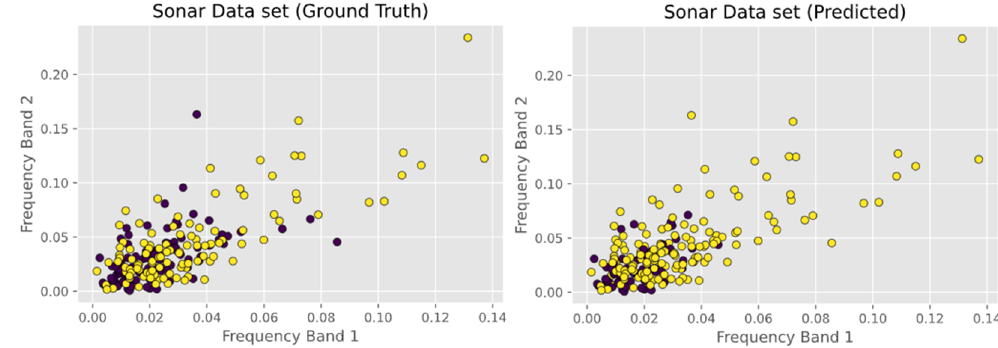
Figure 18. Ground truth vs. predicted labels from FNN-PSO algorithm on Mammographic Mass